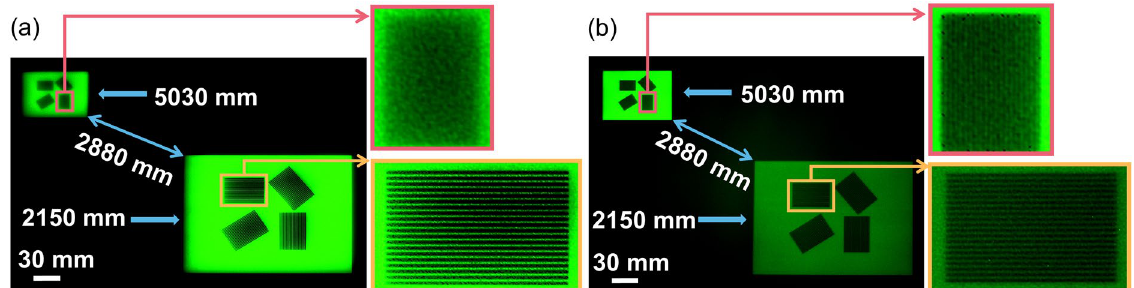
Figure. 7. Long DOF imaging through the short focus. ( a ) Image taken by the refractive lens. ( b ) Image taken by the BDL. The distance between two objects is 2880